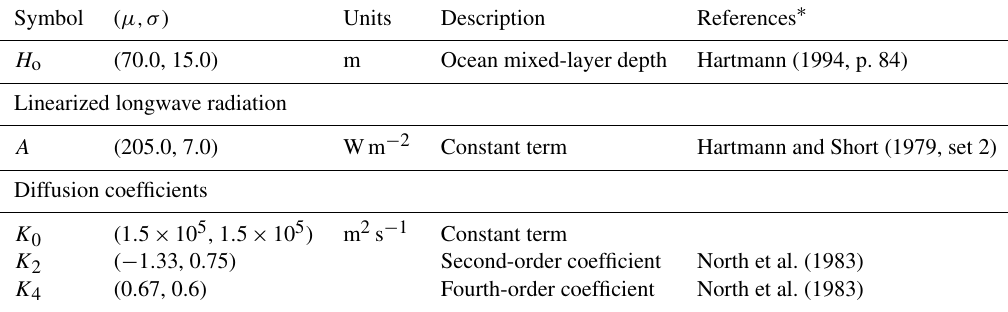
Table 1. 1-D energy balance model. PD1 tests. Parameter definition and first-guess